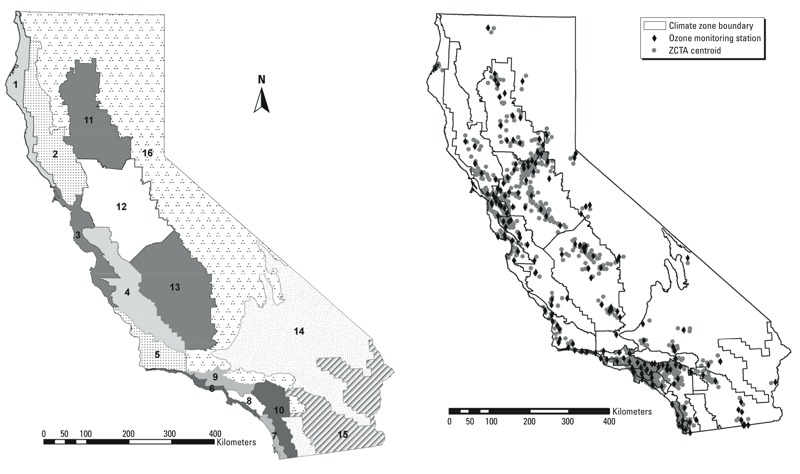
Maps of California CZs and locations of ozone monitors and EDV ZCTA centroids used in this study. CZ boundaries designated by California Energy Commission (2009). Ozone monitor locations provided by CARB (2011).